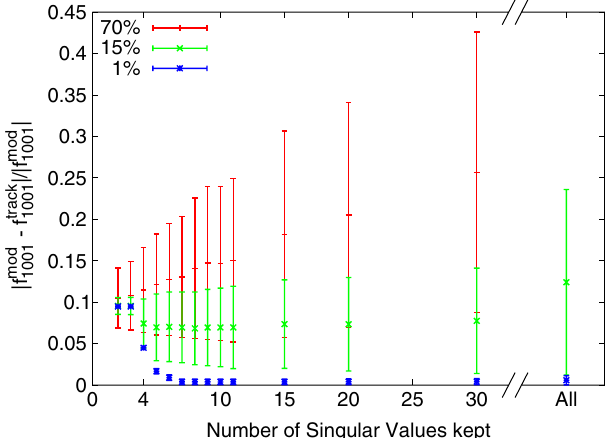
FIG. 3. The relative deviation from the correct coupling as a function of the number of singular values used. The error bars represent the average error bar of all the 502 simulated BPMs. When all singular values are used we are not able to calculate the coupling for the 70% noise case. tracking without any noise and the use of all singular values. Gaussian noise of 1%, 15%, and 70% was added to construct the TbT data used in the analysis. The deviations between the correct coupling and the reconstructed using different numbers of singular values are shown in Fig. 3. The error bars on the plot are the average statistical errors from all available BPMs. The statistical error bars are clearly decreasing with fewer singular values but the deviation from the correct value also increases for the lowest number of singular values, for the 1% and 15% noise cases. From this we conclude that reducing the number of singular values below 8 introduces a systematic error. Truncating at 4 singular values would introduce on average a 5% error due to the mode mixing. The degree of mode mixing depends on the number of BPMs as well as on the number of modes: As a consequence 8 might not be the